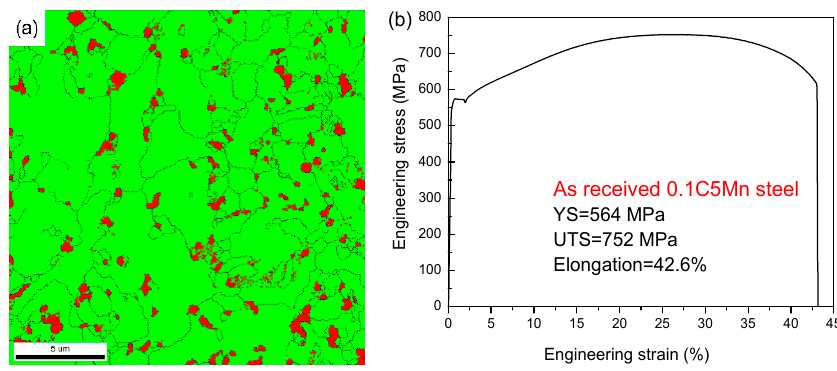
Figure 1. Microstructure and tensile properties of BM (base metal): ( a ) Phase distribution with high angle boundaries obtained by EBSD (red: retained austenite; green: ferrite); ( b ) Engineering stress-strain curve.